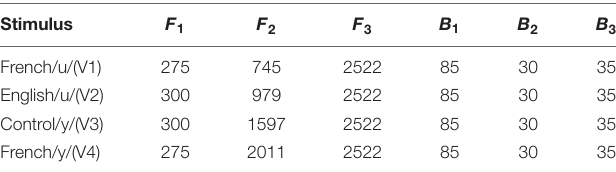
TABLE 1 | Formant frequency and bandwidth (Hz) for the lower formants (F1, F2, and F3) for each vowel stimulus.